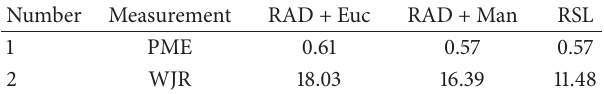
Table 4: Performance for path B under pattern a (61s).